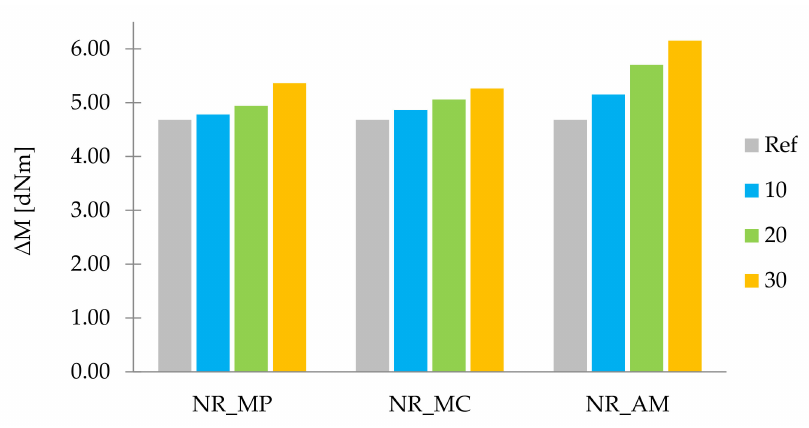
Figure 6. Optimal vulcanization time t 90 (min).